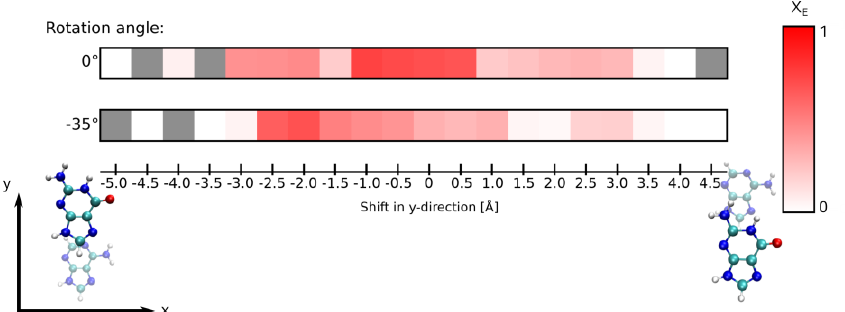
Fig. 2. Exciplexic strength along an exemplary orientational scan between guanine and adenine. The parameter X E is calculated according to eq. (1). It can take values between 1 (strong exciplexic character) and 0 (no exciplexic character) and is encoded in red color according to the bar on the right. The direction of the scan is indicated on the bottom left, with a guanine rotation within its molecular plane of 0° (according to the depicted geometries) and 35°. X E takes the largest values at overlapping geometries. The oscillatory behavior (maximum values at –2.5 Å, 0 Å and 2.5 Å in the 0° scan) is due to one ring, two rings and again one ring